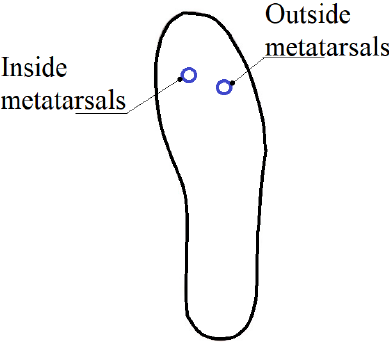
Figure 18. Points for utilization of vertical foot force.